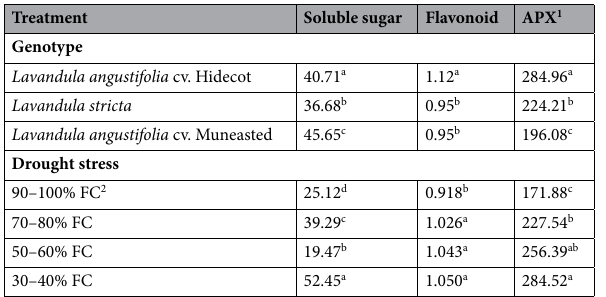
Table 3. Comparing simple effects of genotype and drought stress on traits of lavender plant. 1. APX, Ascorbate peroxidase, 2. Field capacity. Different letters on top of column indicate significant different at P ≤ 0.05 according to the LSD test.